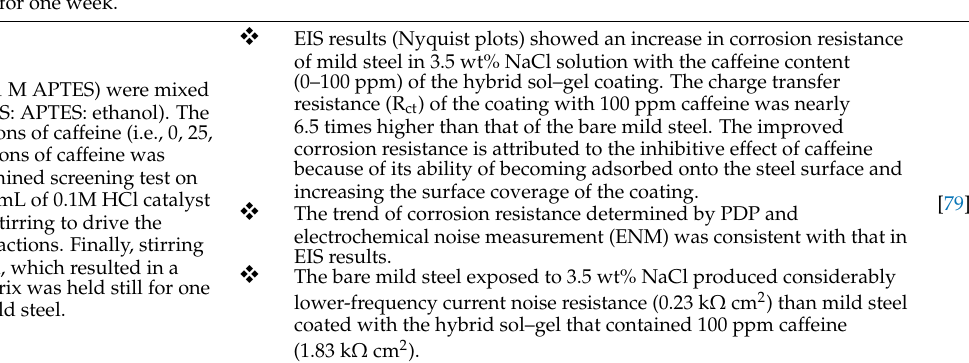
Table 1. Different approaches for improving silane coatings and the main findings, as reported in the literature.